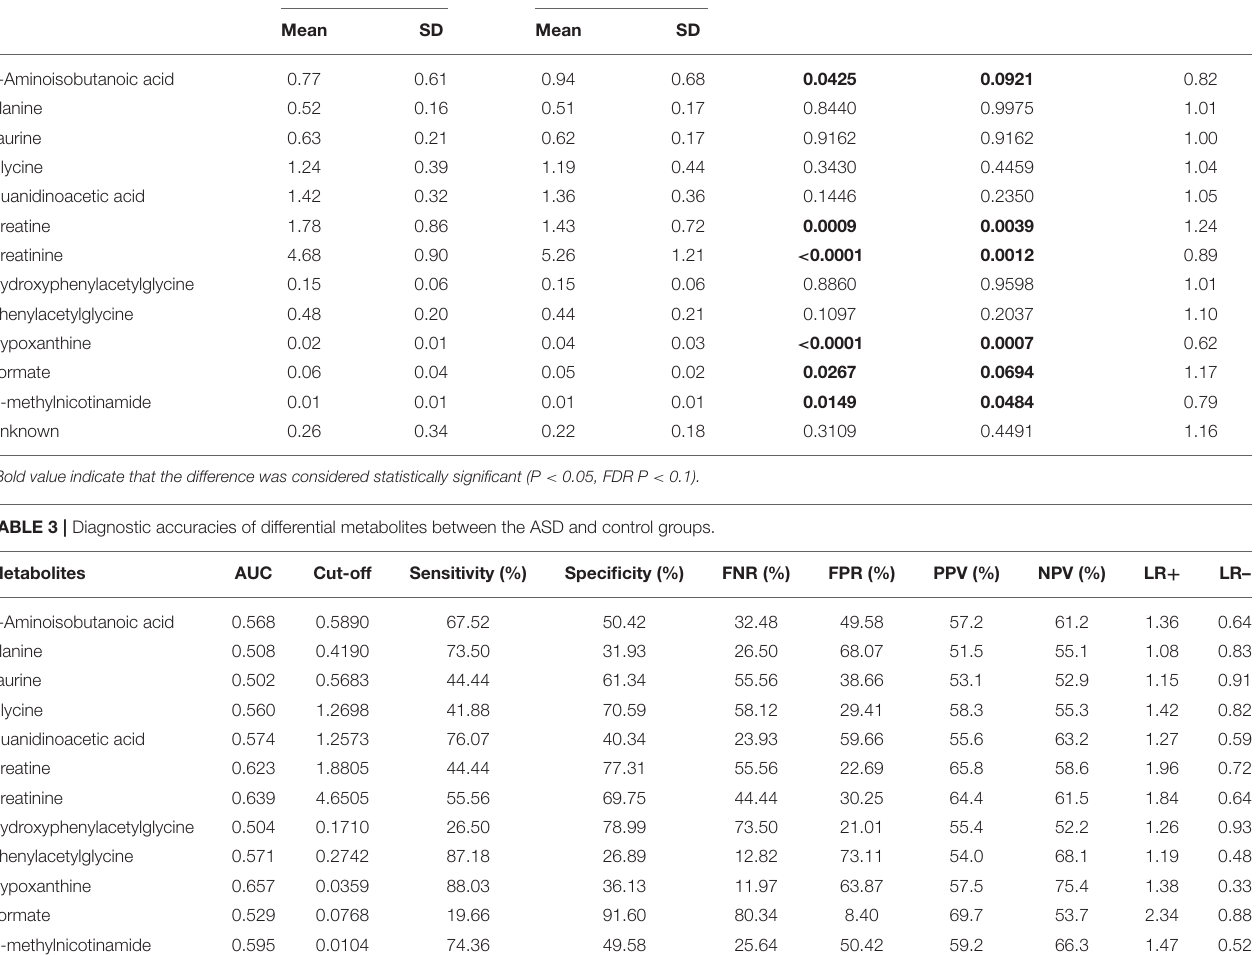
( Table 2 ). Correlation analysis showed that the level of creatinine